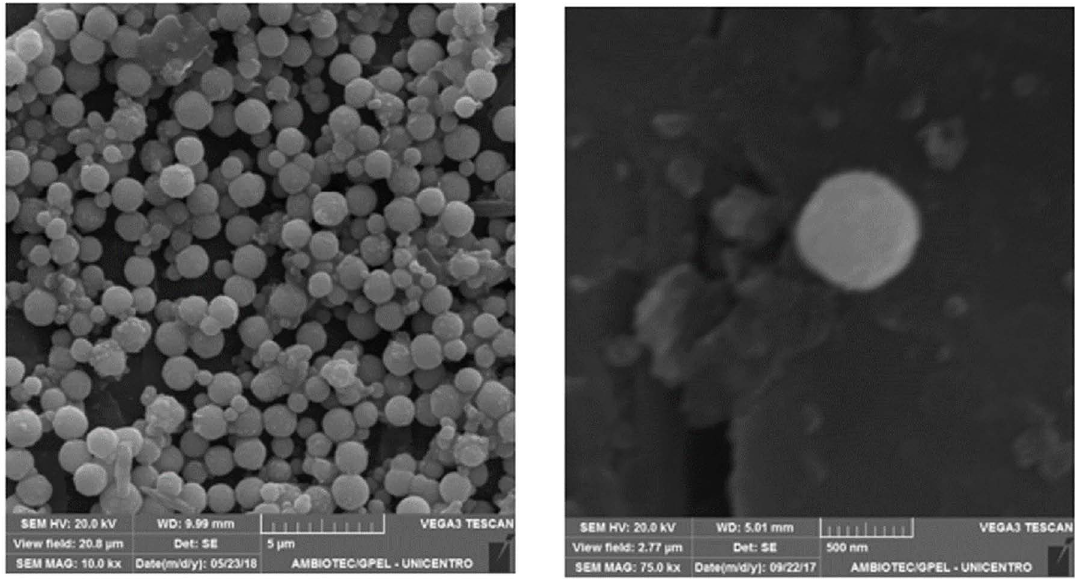
Figure 3. SEM images of ZnO particles synthesized by coprecipitation.